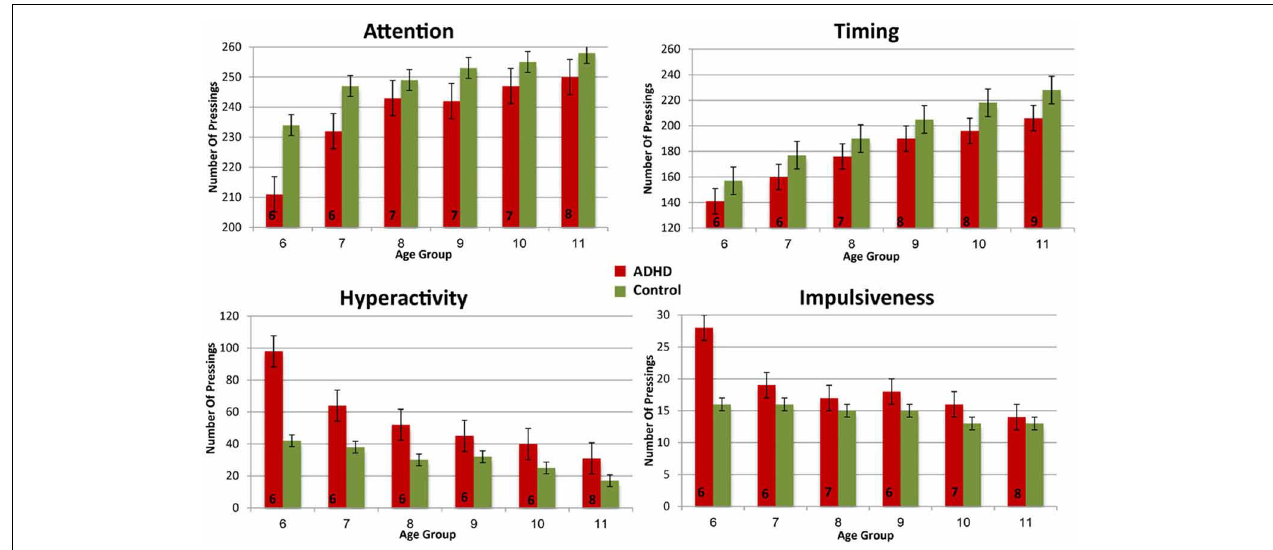
FIGURE 2 | Performance in four CPT parameters among ADHD children and control group.